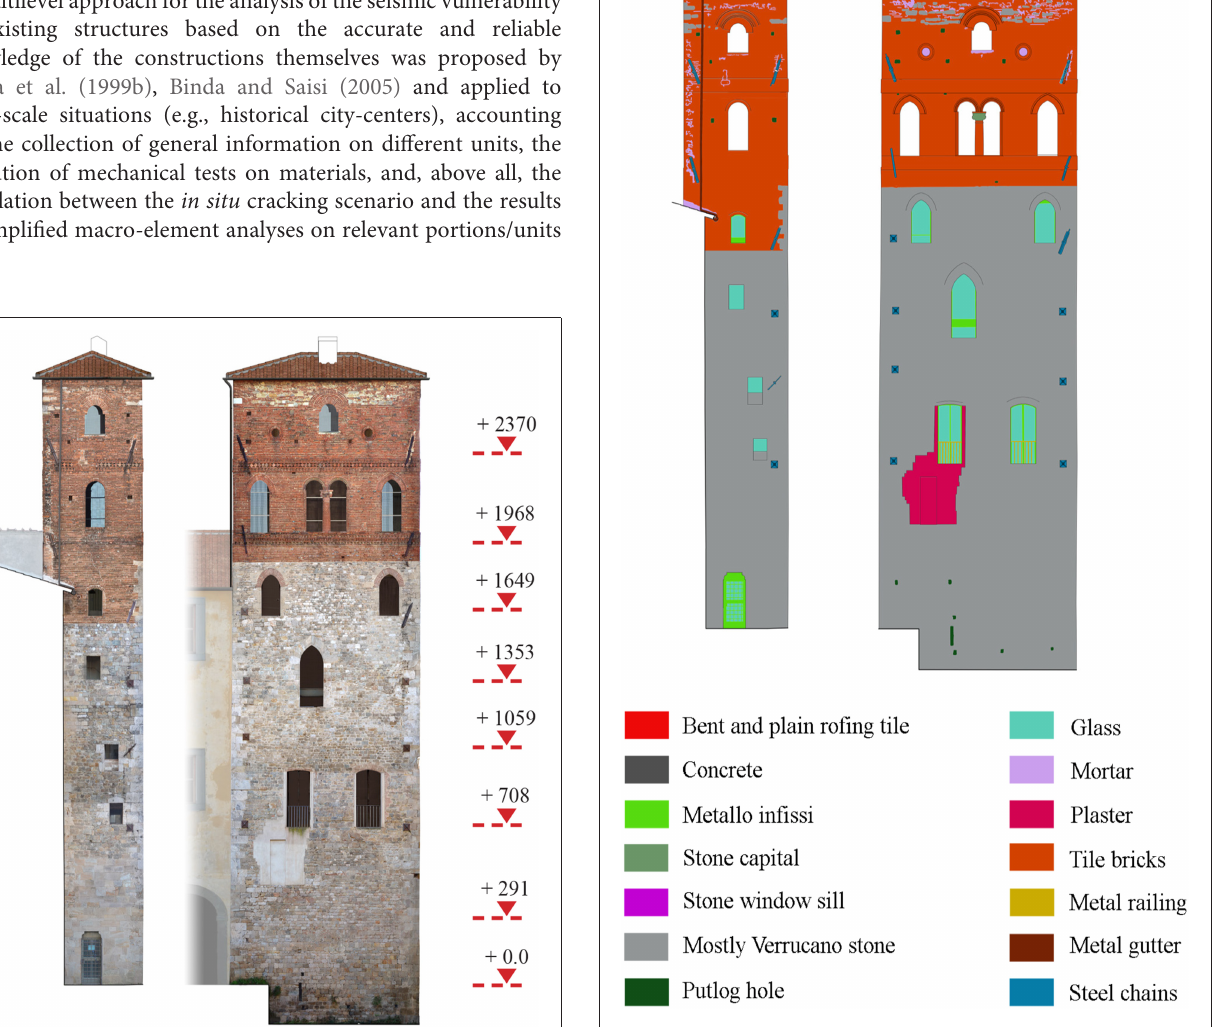
FIGURE 1 | East and north façades of the Lanfreducci Tower.